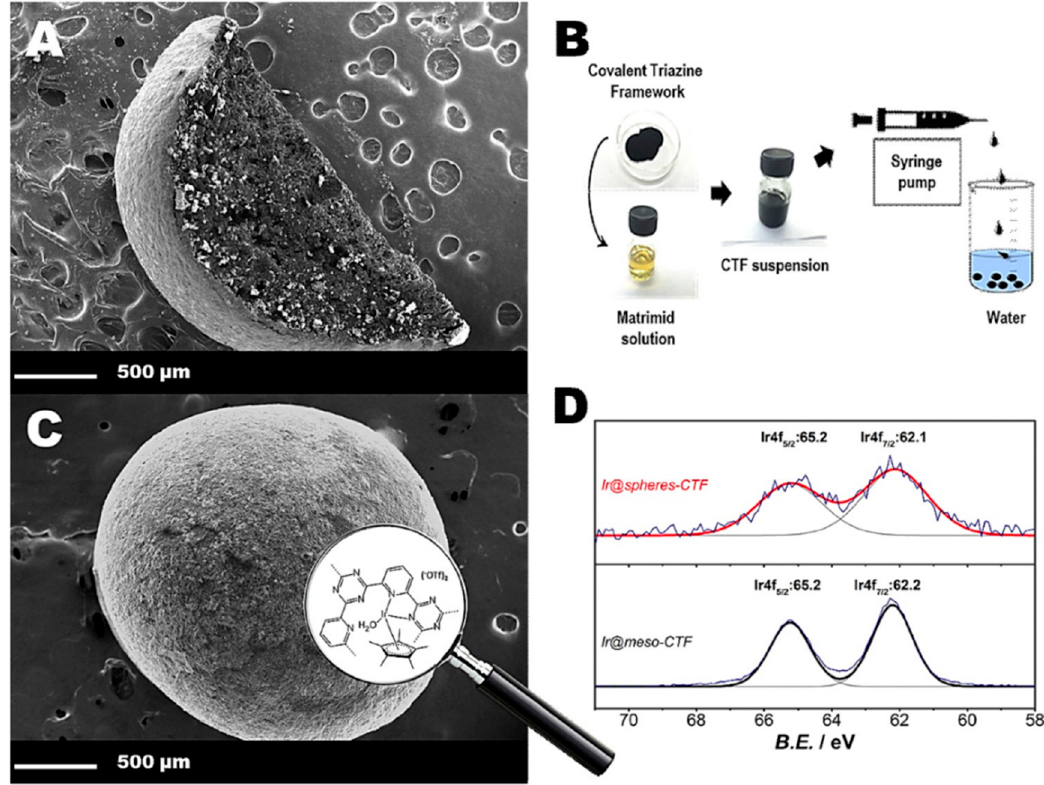
Figure 4. ( A ) SEM of a cut CTF-based sphere; ( B ) synthesis conditions for the shaping of CTF; ( C ) SEM image and its molecular structures of immobilized Ir complex on the CTF-based sphere; ( D ) XPS analysis of iridium species in the powder and shaped CTF catalysts (Reprinted with permission from [44]. Copyright 2016, Wiley-VCH).